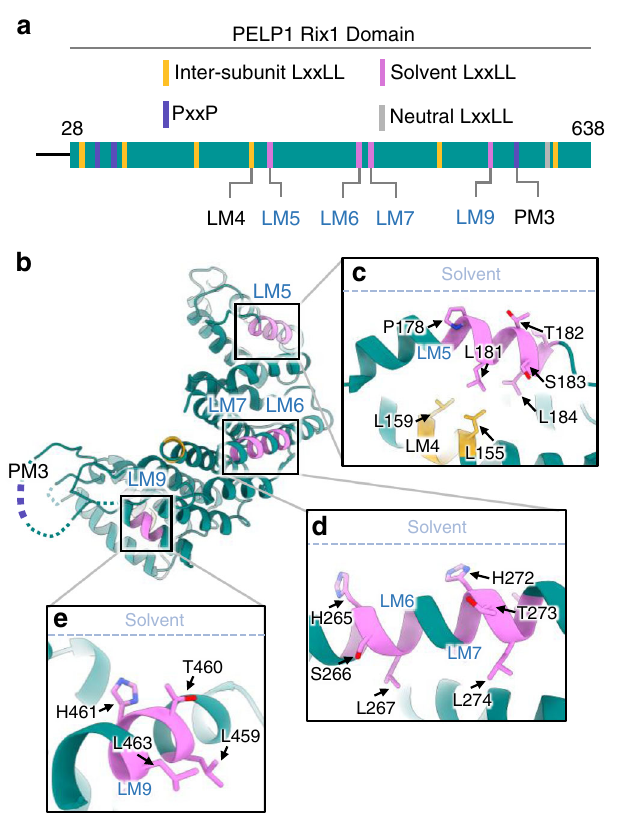
Fig. 5 | PELP1 ’ s solvent-exposed LxxLL motifs are incompatible with steroid receptor binding. a Schematic representation of PELP1 ’ s Rix1 domain with locali- zation ofLxxLLand PxxP motifs. Motifsillustratedinmodelviews are noted below the schematic (solvent motif labels colored blue). b Model view of a single PELP1 Rix1 domain protomer with solvent-exposed LxxLL motifs colored magenta. c , d , e Individual zooms of each solvent LxxLL motif with residue positions dis- played. Solvent face is illustrated in each panel with dashed line for spatial orien- tationofthemotifs.TheinvariantleucineresiduesrequiredforAF-2bindingofSRs are buried away from the solvent face,rendering theminaccessiblefor